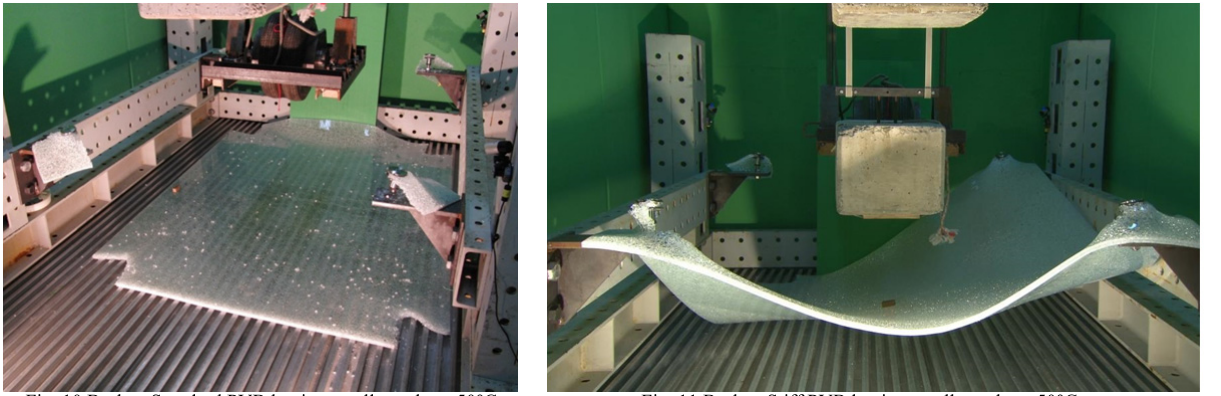
Fig. 11 Broken Stiff PVB laminate collapsed at